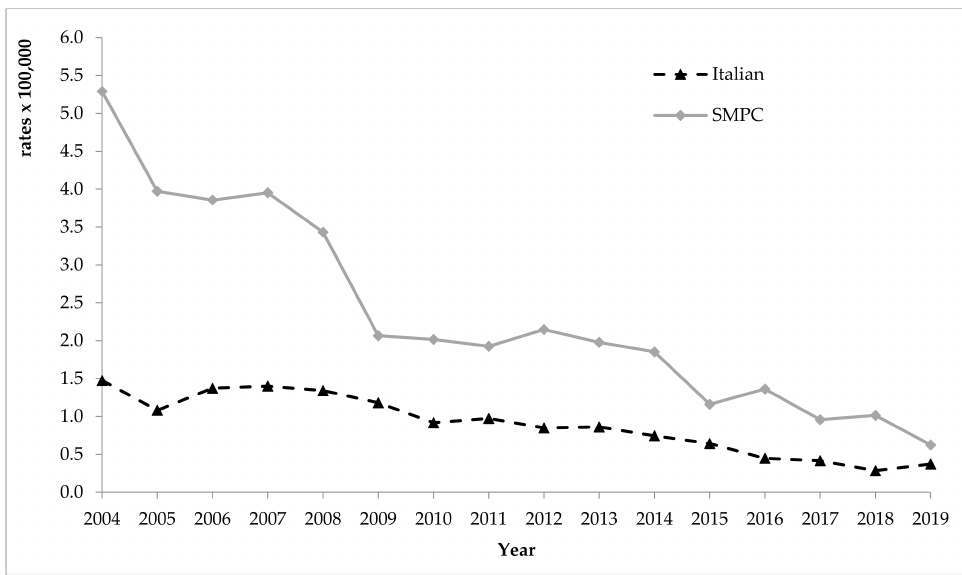
Figure 2. Incidence rates (standardised per 100,000) of viral acute hepatitis B in the foreign population from SMPC and among Italians, years 2004–2019. SMPC—Strong Migratory Pressure Countries.